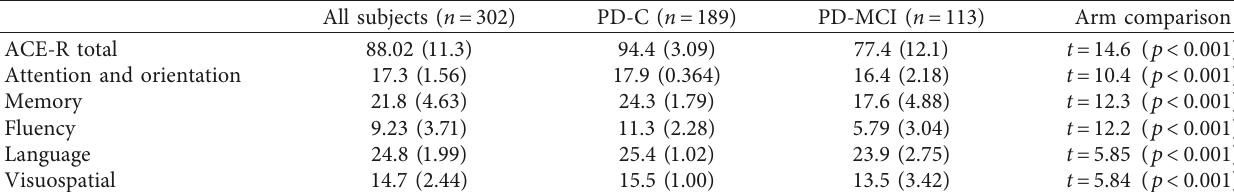
Table 1: Differences in ACE-R subdomain scores in the PD-C and PD-MCI groups.